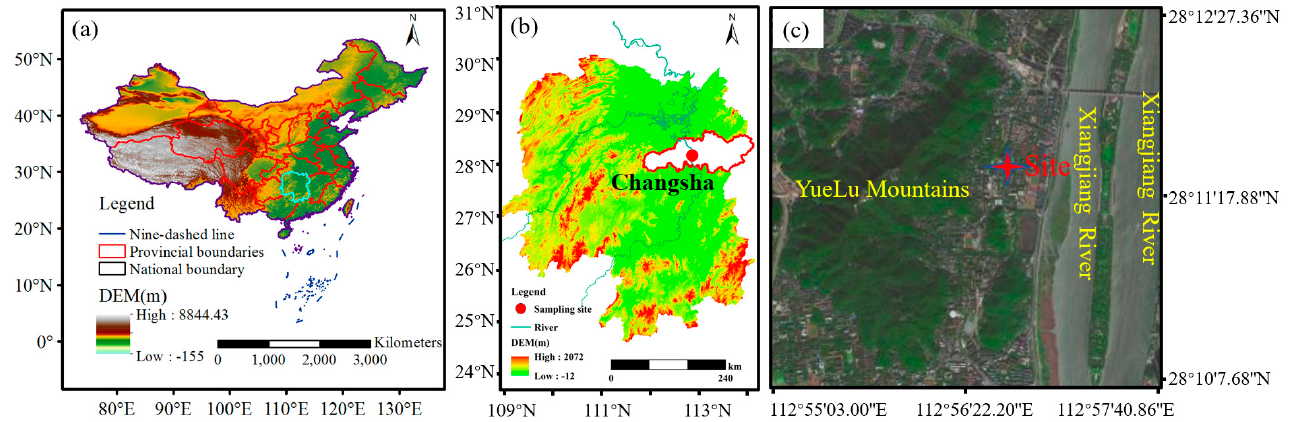
Figure 1. ( a ) Topographic map of China. ( b ) Topographic map of Hunan. ( c ) Locations of sampling sites and weather stations at Hunan Normal University.